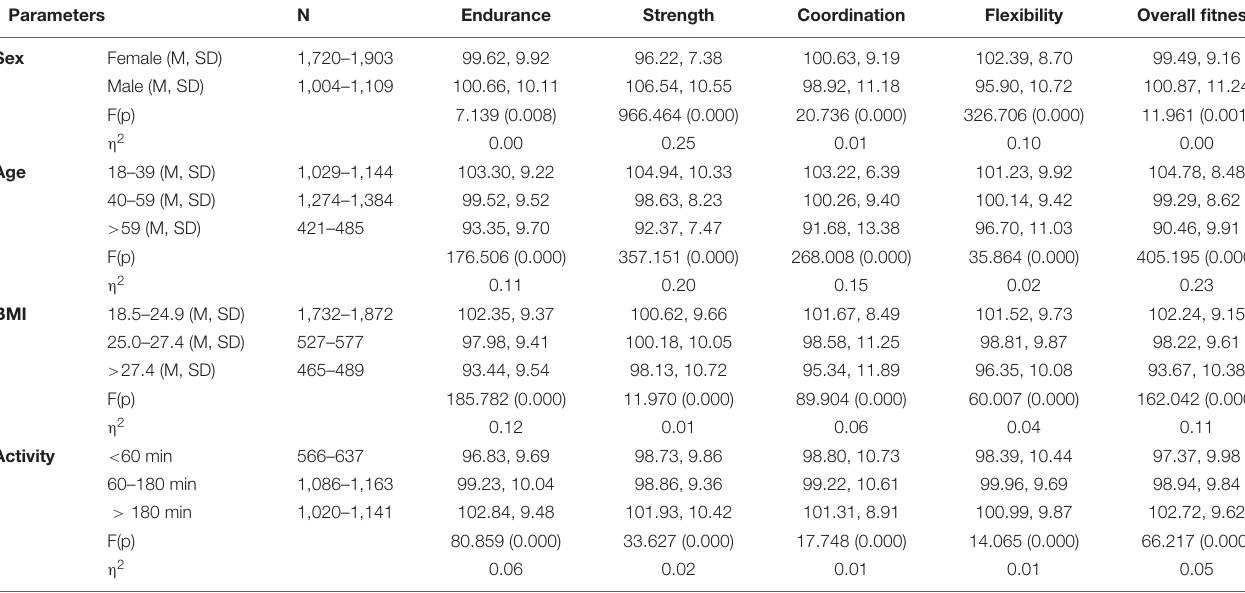
TABLE 3 | Results from one-factorial ANOVA on the impact of sex, age, body composition, and physical activity on fitness test performance. Parameters N Endurance Strength Coordination Flexibility Overall